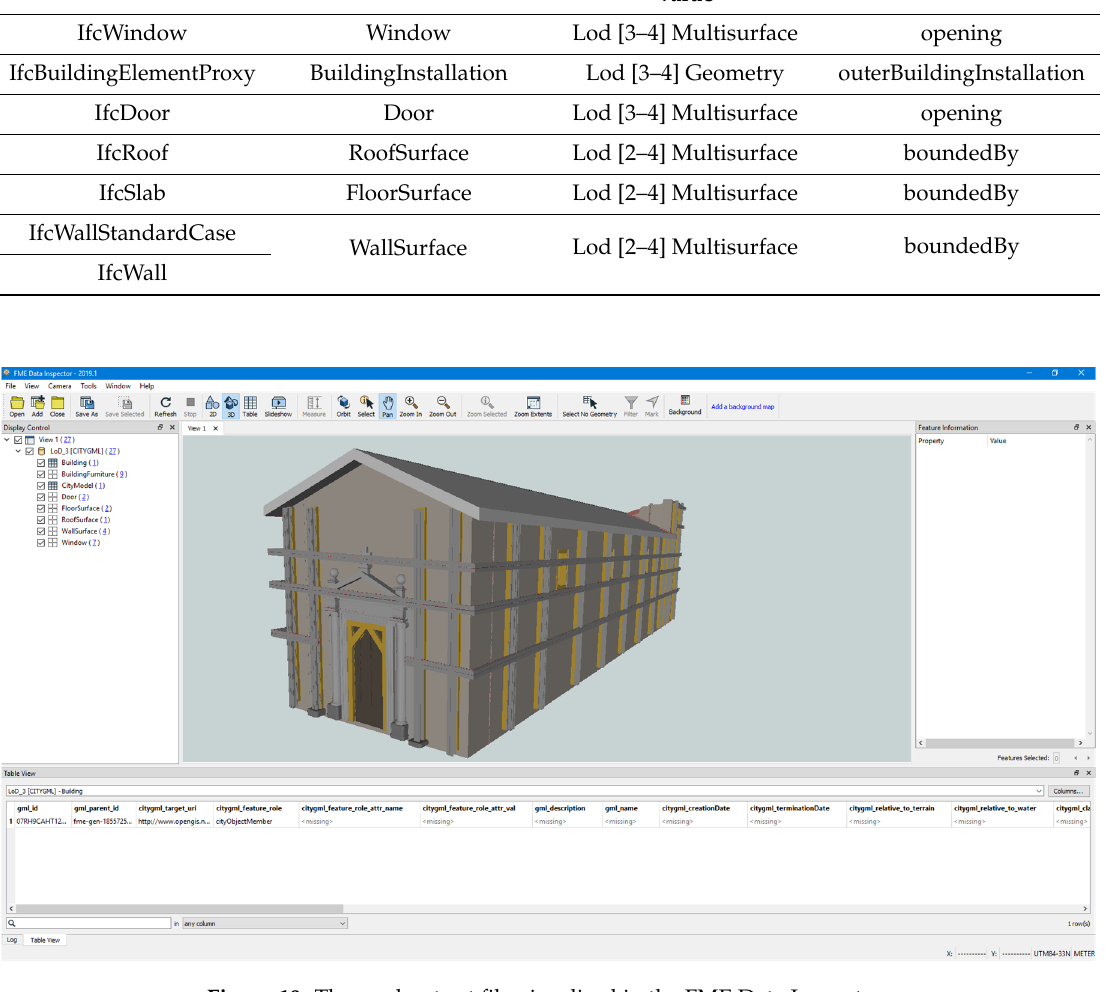
Figure 19. The .gml output file visualised in the FME Data Inspector.